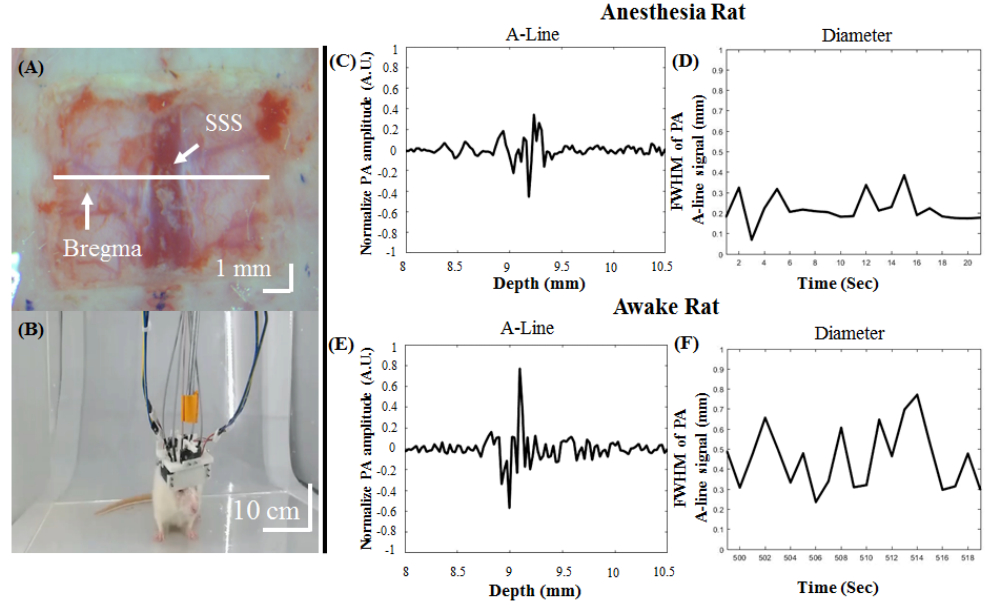
Figure 6. In vivo PA 800 signals from diameter changes in cortical SSS blood vessels at the bregma position from awake and anesthetized rats. ( A ) Photograph of the rat brain after craniotomy for the addition of the developed hmPAI system. ( B ) Representative movie depicting awake and freely moving experimental rats wearing the hmPAI system (Movie S3). ( C , D ) Normalized and FWHM PA 800 A-line cortical SSS blood vessel signals at bregma in anesthetized rats (Movie S4). The diameter of cerebral blood vessels in rats under anesthesia was approximately between 0.07 and 0.41 mm. ( E , F ) Normalized and FWHM PA 800 A-line cortical SSS blood vessel signals at bregma in awake rats (Movie S4). In this awake rat study, the diameter of the selected SSS blood vessels of the rat ranged from 0.27 to 0.78